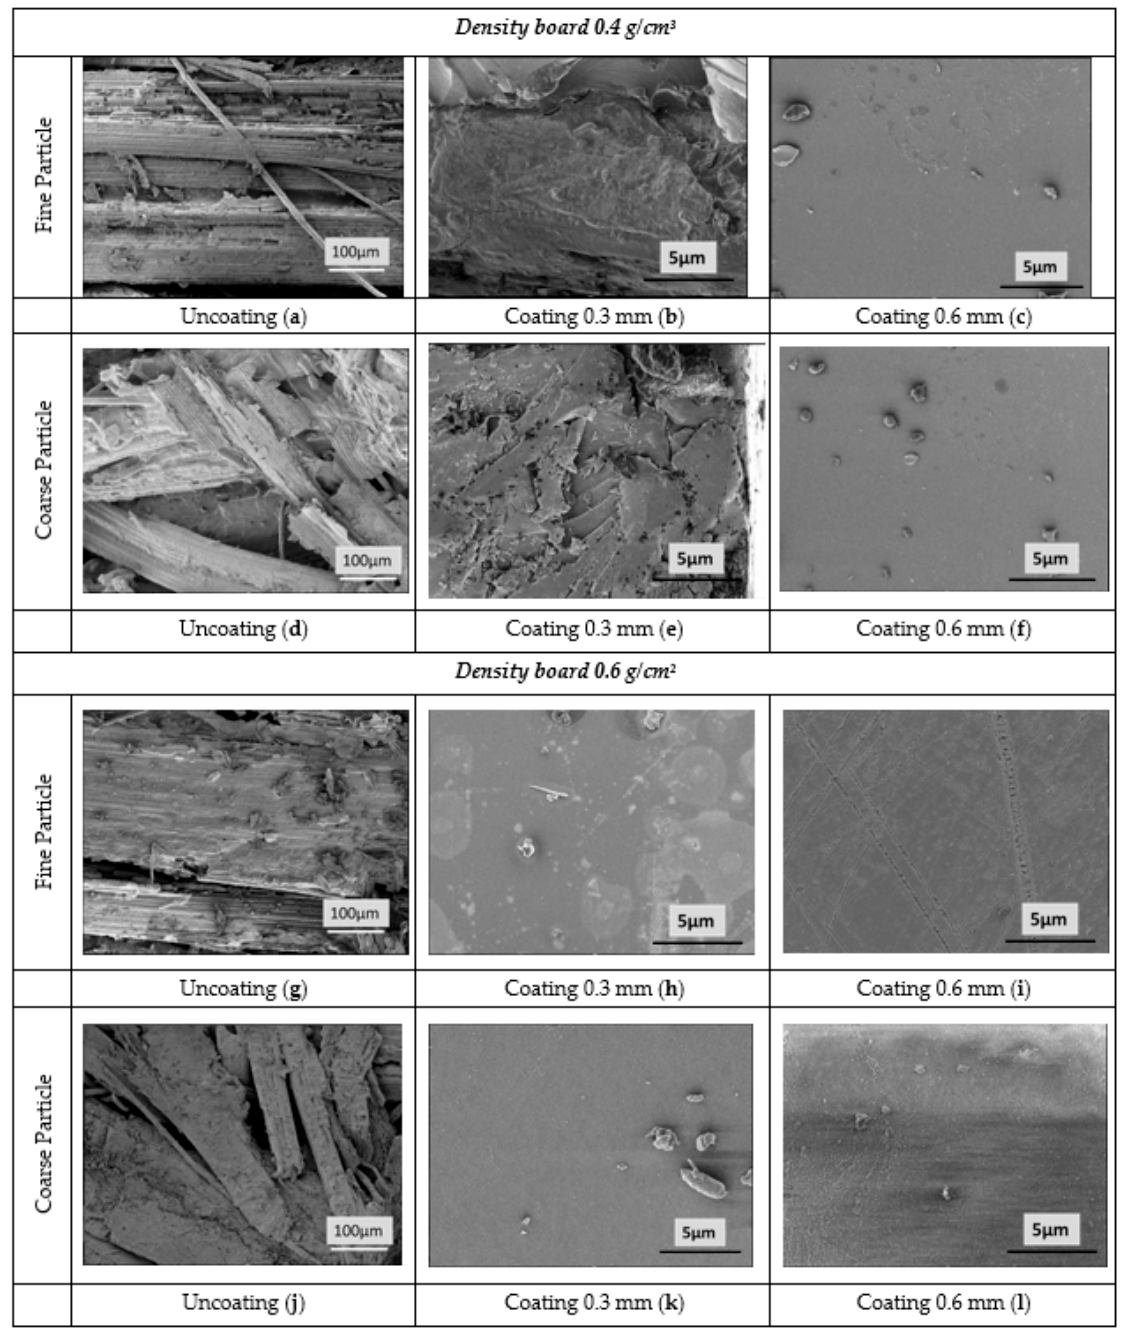
Figure 4. SEM images of uncoating ( a , d , g , j ) in 100 × magnification; and coating treatment with 0.3 mm ( b , e , h , k ) and 0.6 mm ( c , f , i , l ) thickness coating at bamboo particle board (2000 × magnification).